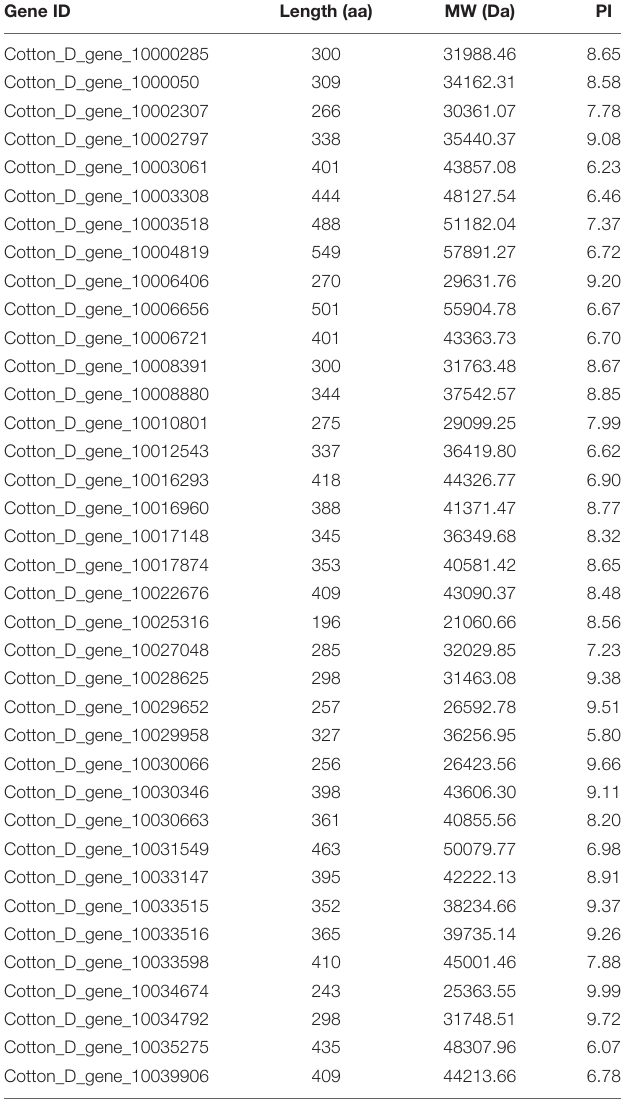
TABLE 1 | TCP gene family in G. raimondii